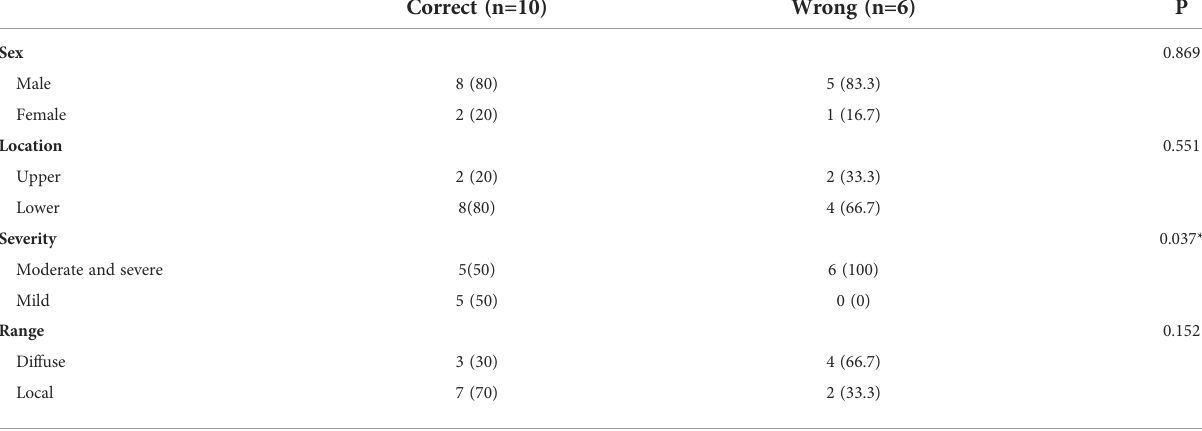
TABLE 5 Univariate analysis of diagnostic errors of atrophy combined with intestinal